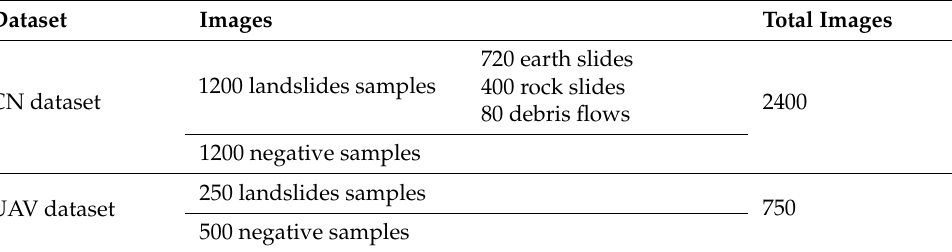
Table 1. The dataset in this paper. Each sample is an image, the landslide sample contains one to more landslides, and there are no landslides in the negative sample.